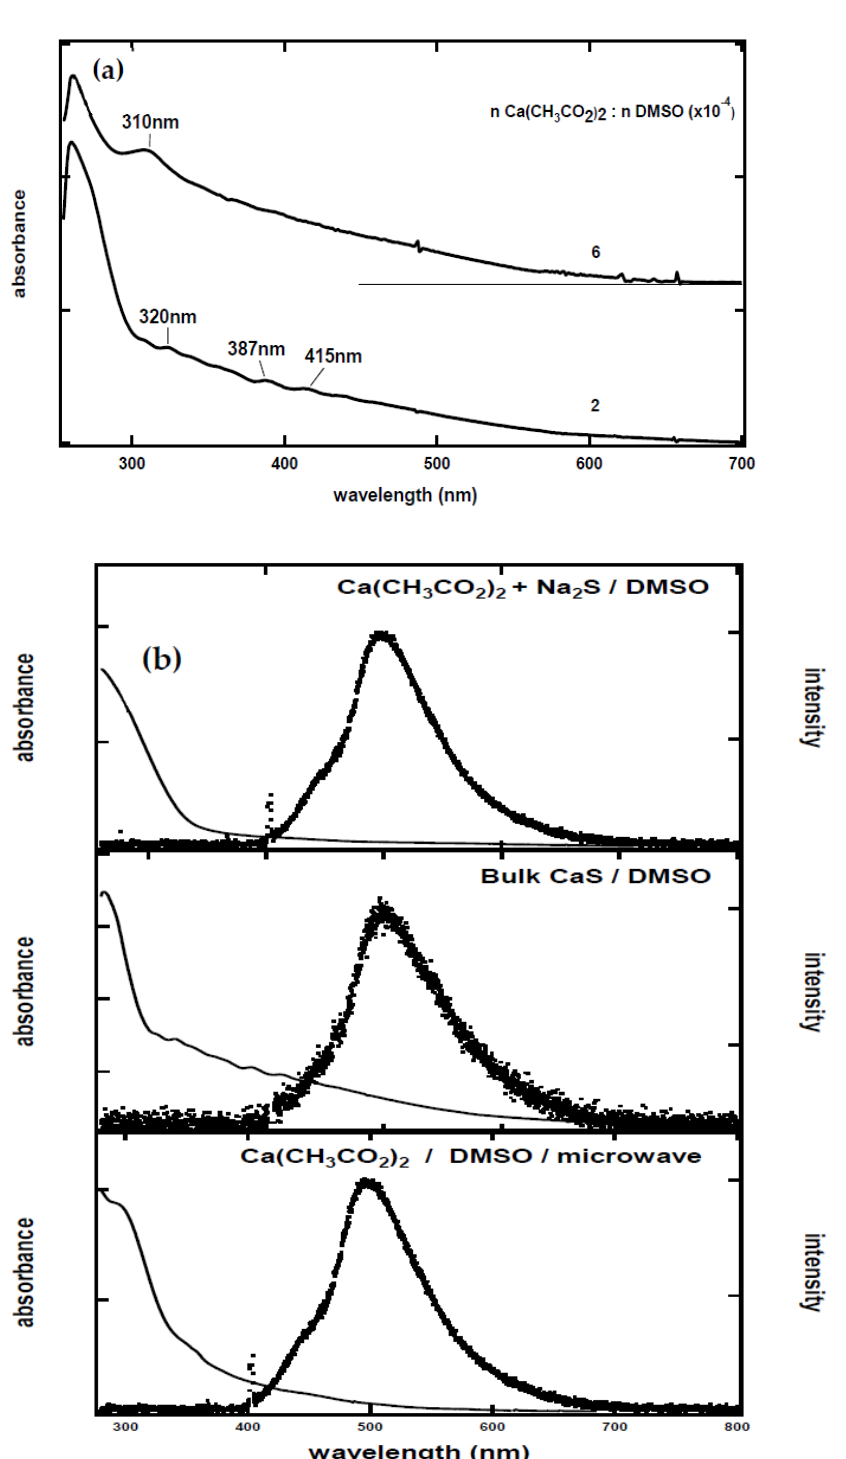
Figure 1. ( a ) UV-visible spectra of CaS nanostructures prepared from the reaction of Ca(CH 3 CO 2 ) 2 with DMSO in a microwave. The Ca(CH 3 CO 2 ) 2 to DMSO ratios of the spectra are ( a ) 2 × 10 − 4 and ( b ) 6 × 10 − 4 . ( b ) Absorption and emission spectra of CaS prepared from the double ion exchange reaction in DMSO ( top ), dissolution of bulk CaS in DMSO ( middle ), and microwave decomposition of Ca(CH 3 CO 2 ) 2 in DMSO ( bottom